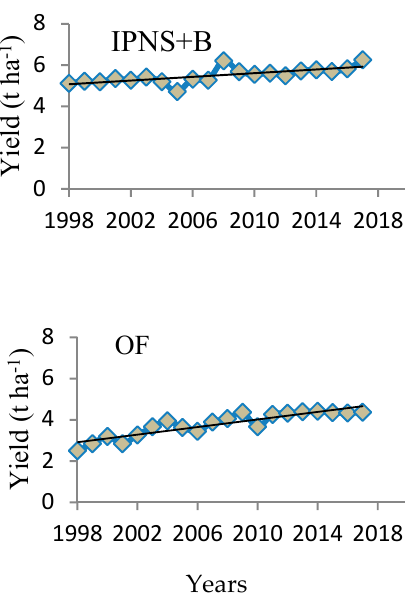
Figure 2. Trends in yields of rice and wheat in a long-term RWS under different nutrient management options. Measured mean yields of the treatments (symbols) and the trend line fitted by linear regression (Table 3) are shown.